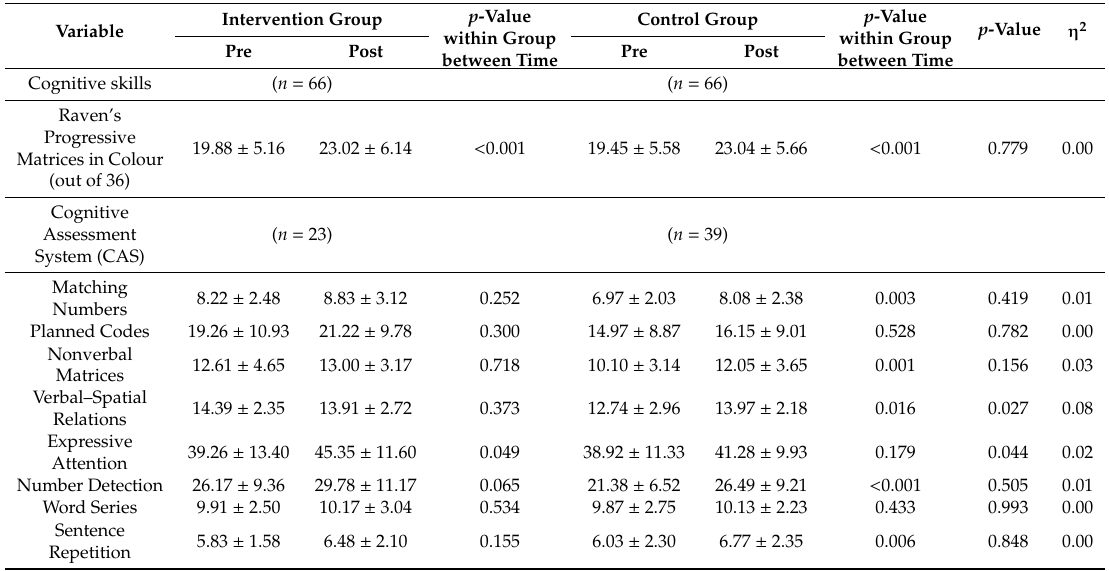
Table 4. Cognitive skills